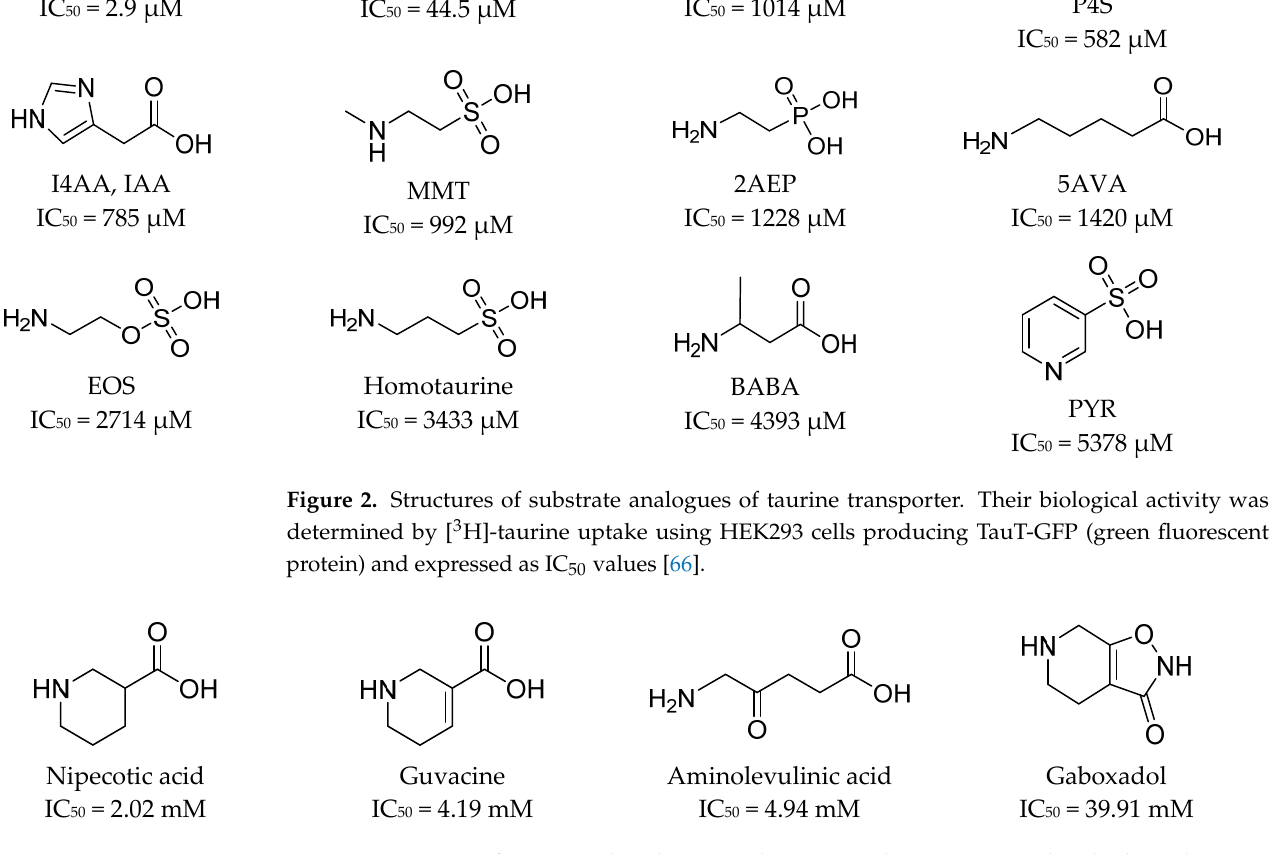
Figure 3. Structure of GABA and β -alanine analogues tested against TauT. Their biological activity was determined by [ 3 H]-taurine uptake using SKPT cells and expressed as IC 50 values. Compounds are sorted according to the increasing IC 50 values [67].